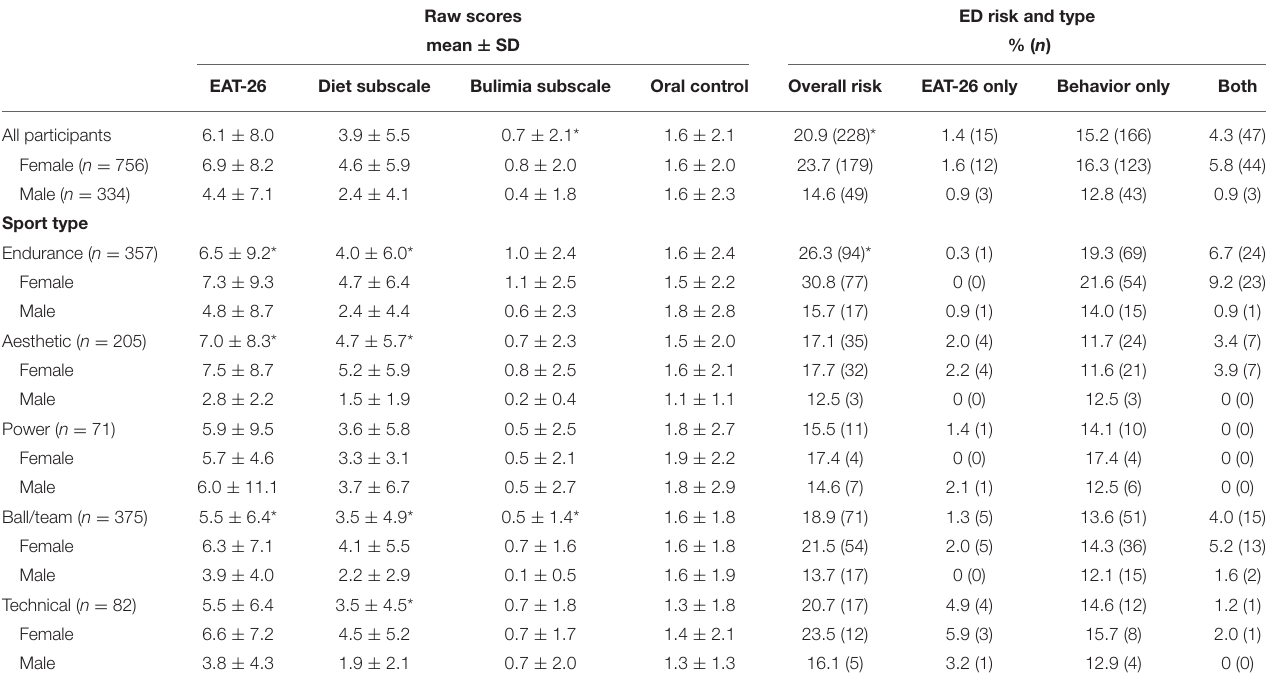
TABLE 3 | Risk for EDs across collegiate athletes using EAT-26 and pathogenic behaviors.